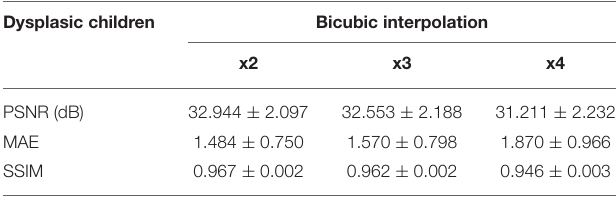
TABLE 5 | Results for different metrics and scaling factors among dysplasic children test set using bicubic interpolation method.